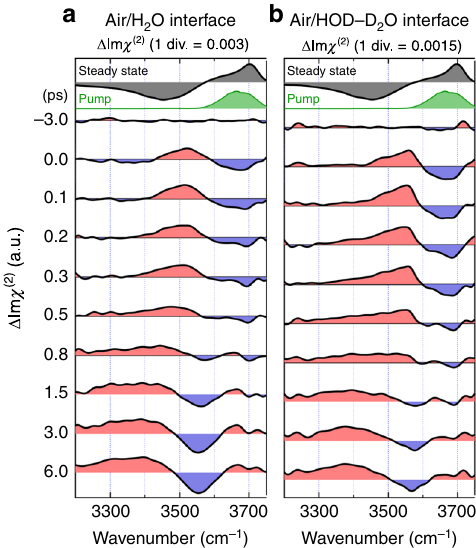
Fig. 2 Time-resolved Δ Im χ (2) spectra of the air/water interfaces. Time- resolved Δ Im χ (2) spectra from − 3.0 to 6.0 ps obtained with selective excitation of the free OH, a neat H 2 O and b isotopically diluted water (H 2 O/HOD/D 2 O = 1/2/1) interfaces. The time shown along the vertical axis represents the delay time of each time-resolved Δ Im χ (2) spectrum. Red and blue regions in the spectra are positive and negative changes from the steady-state Im χ (2) spectrum, respectively. The steady-state Im χ (2) spectrum and the spectrum of the pump pulse are also shown at the top, for